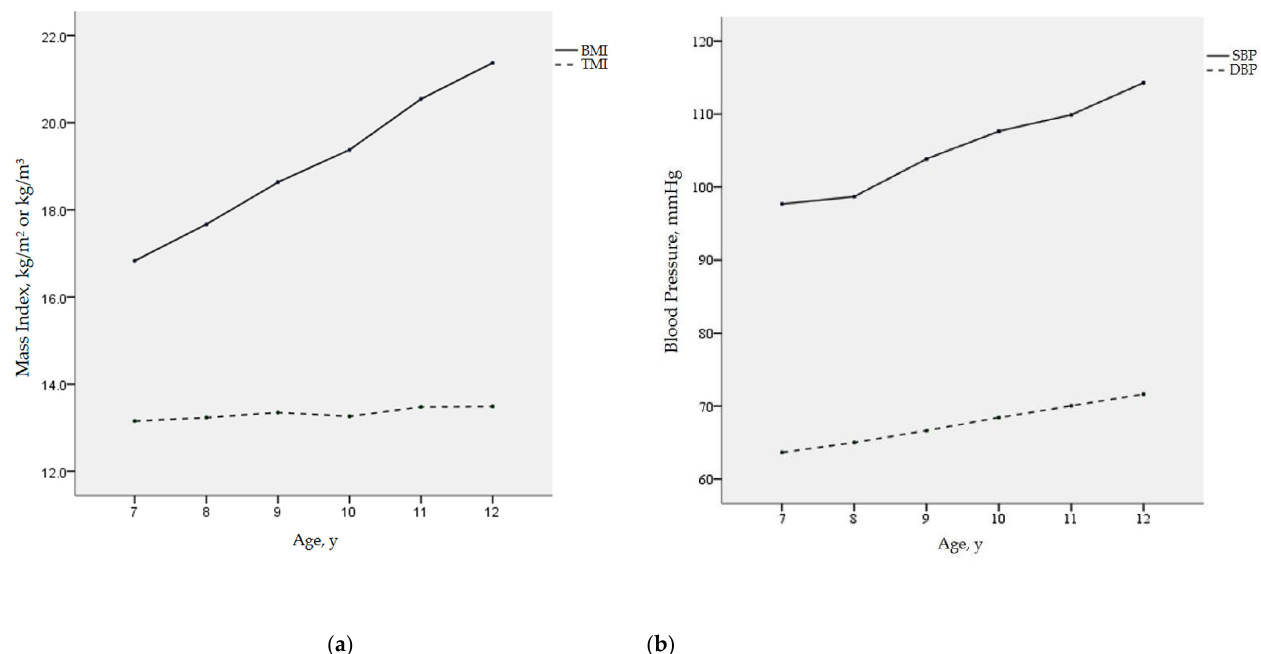
Figure 1. Mean values of BMI, TMI, SBP, and DBP with age: ( a ) BMI and TMI with age; ( b ) SBP and DBP with age; BMI, body mass index; TMI, tri-ponderal mass index; SBP, systolic blood pressure; DBP, diastolic blood pressure.